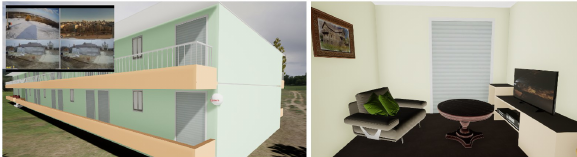
Figure 12 . An example of remotely accessing the surveillance cameras (left) and a computer smart device of the building